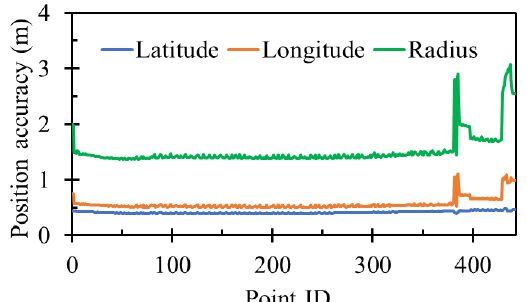
Figure 6. Geopositioning accuracy of tie points for LRO NAC images (our method).